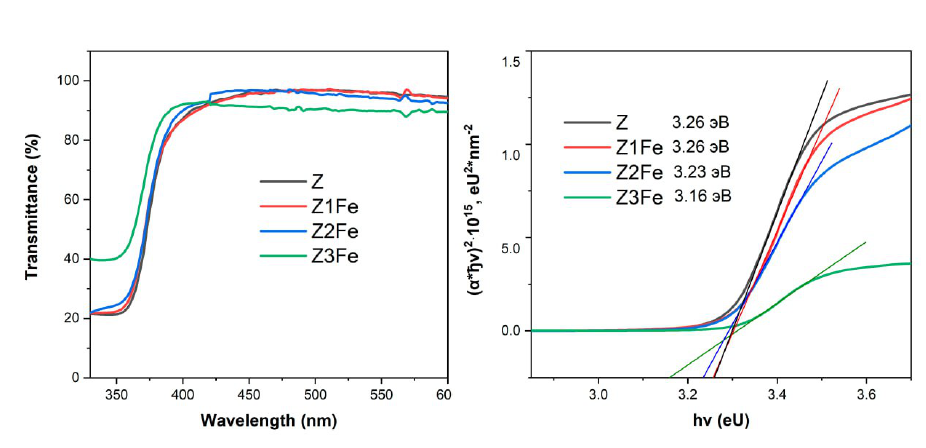
Figure 7. UV transmittance spectra ( a ) and Tauc plot ( b ) for thin films of ZnO/Fe 2 O 3